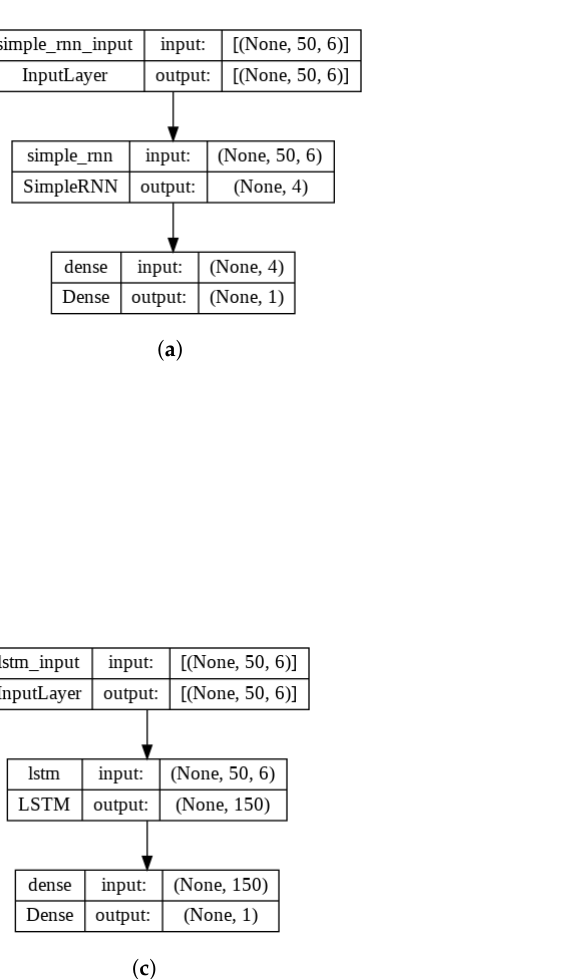
Figure 8. Structure of DL models used for training. ( a ) Recurrent Neural Network (RNN) Architecture. ( b ) Multilayer Perception (MLP) Architecture. ( c ) Long Short-Term Memory (LSTM) Architecture. ( d ) Convolutional Neural Network (CNN)